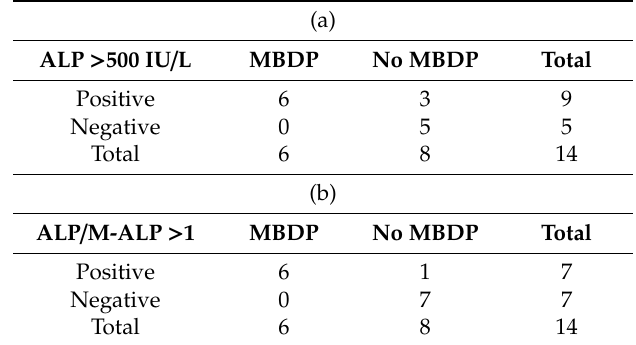
Table 3. Number of patients from the Cholestasis Group (ChG) with and without criteria of MBDP. Number of preterm infants with serum ALP > 500 IU / L (a) and an ALP / M-ALP ratio > 1